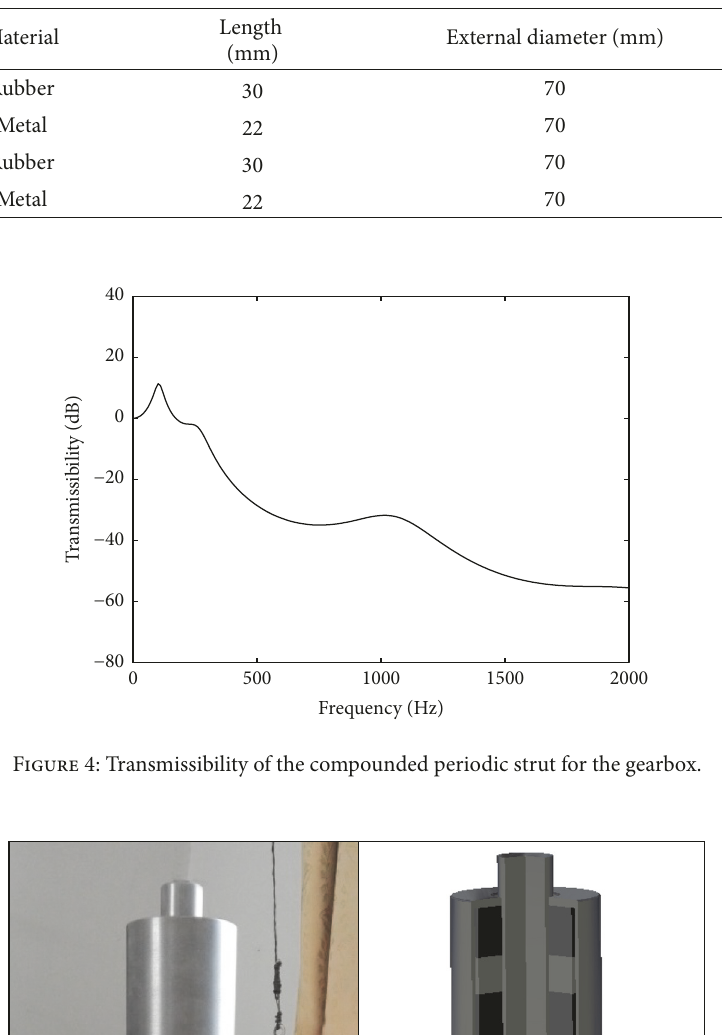
Table 2: Main geometric dimension.